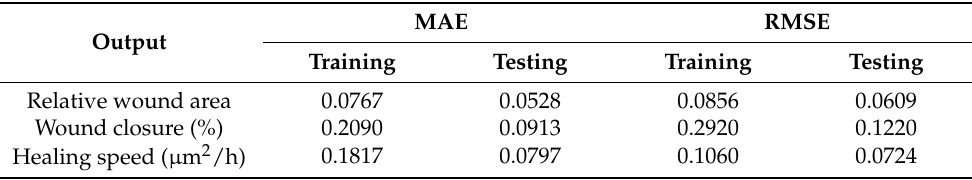
Table 6. The average MAE and RSME for outputs for training and testing data.